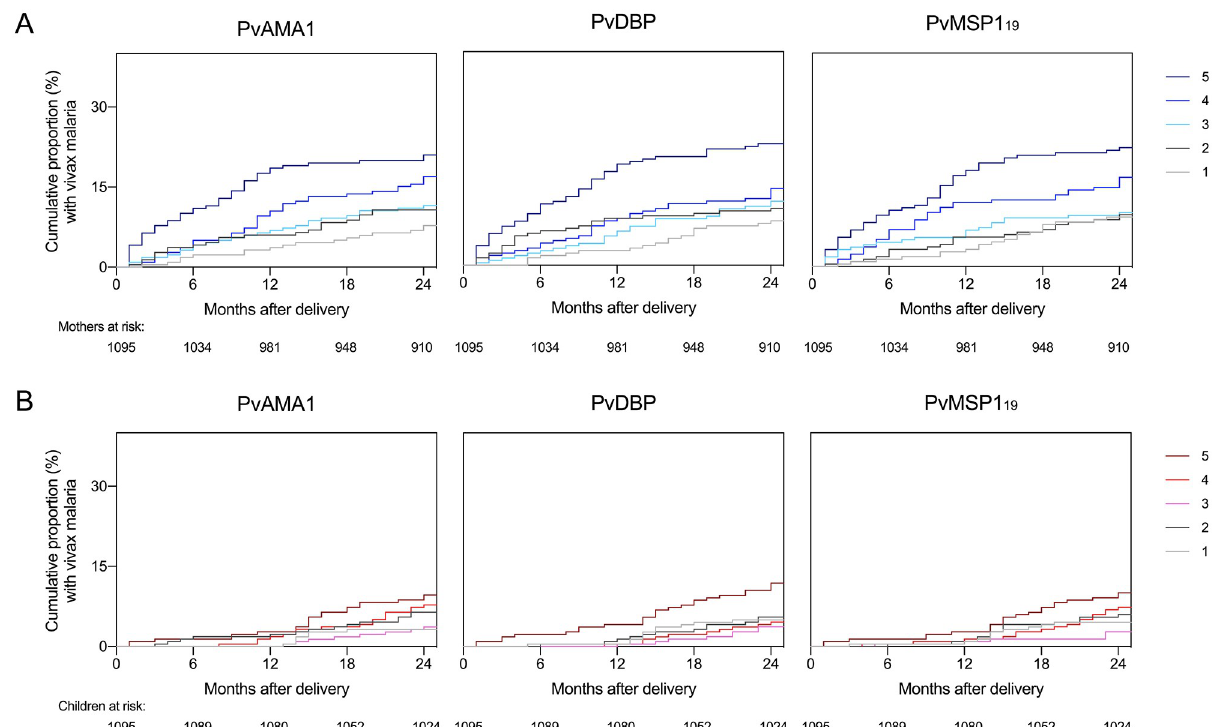
Fig 6. Maternal antibodies and risk of Plasmodium vivax malaria. Cumulative proportions of mothers (A) and their children (B) participating in the MINA-Brazil study who had vivax malaria over 2 years of follow-up are shown according to levels of antibodies to the blood-stage P . vivax antigens PvAMA-1, PvDBP, and PvMSP1 19 measured at delivery and stratified in quintiles (1 = lowest antibody levels). Children and mothers were censored at the time they had falciparum malaria.